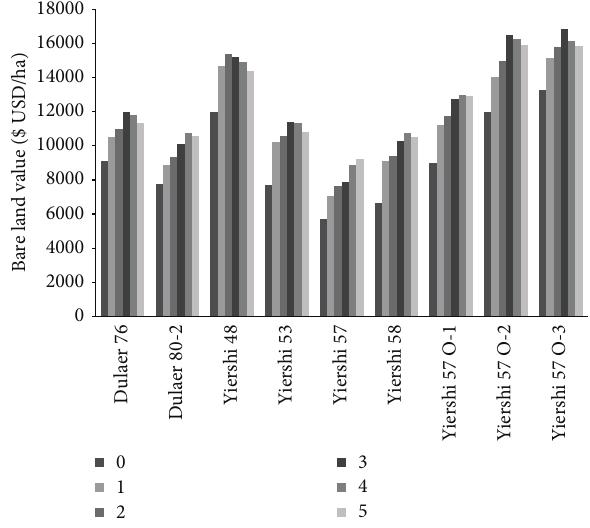
Figure 2: Sensitivity of the maximal bare land value to the number of thinnings on various sample